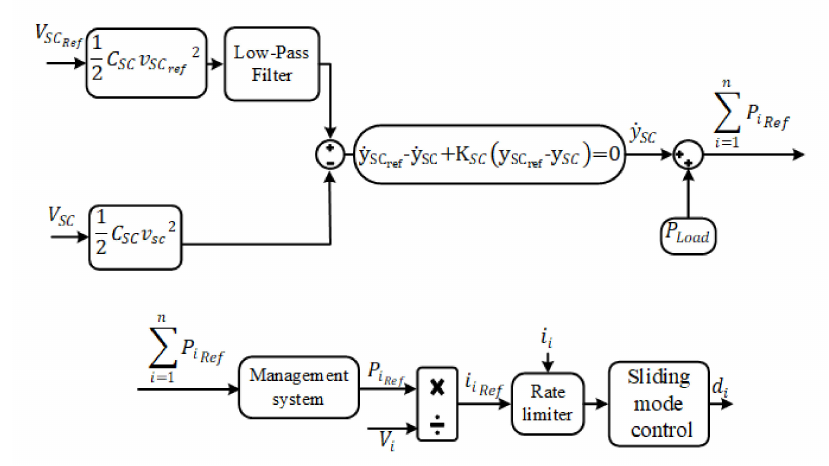
Figure 9. Schematic diagram of the SC voltage